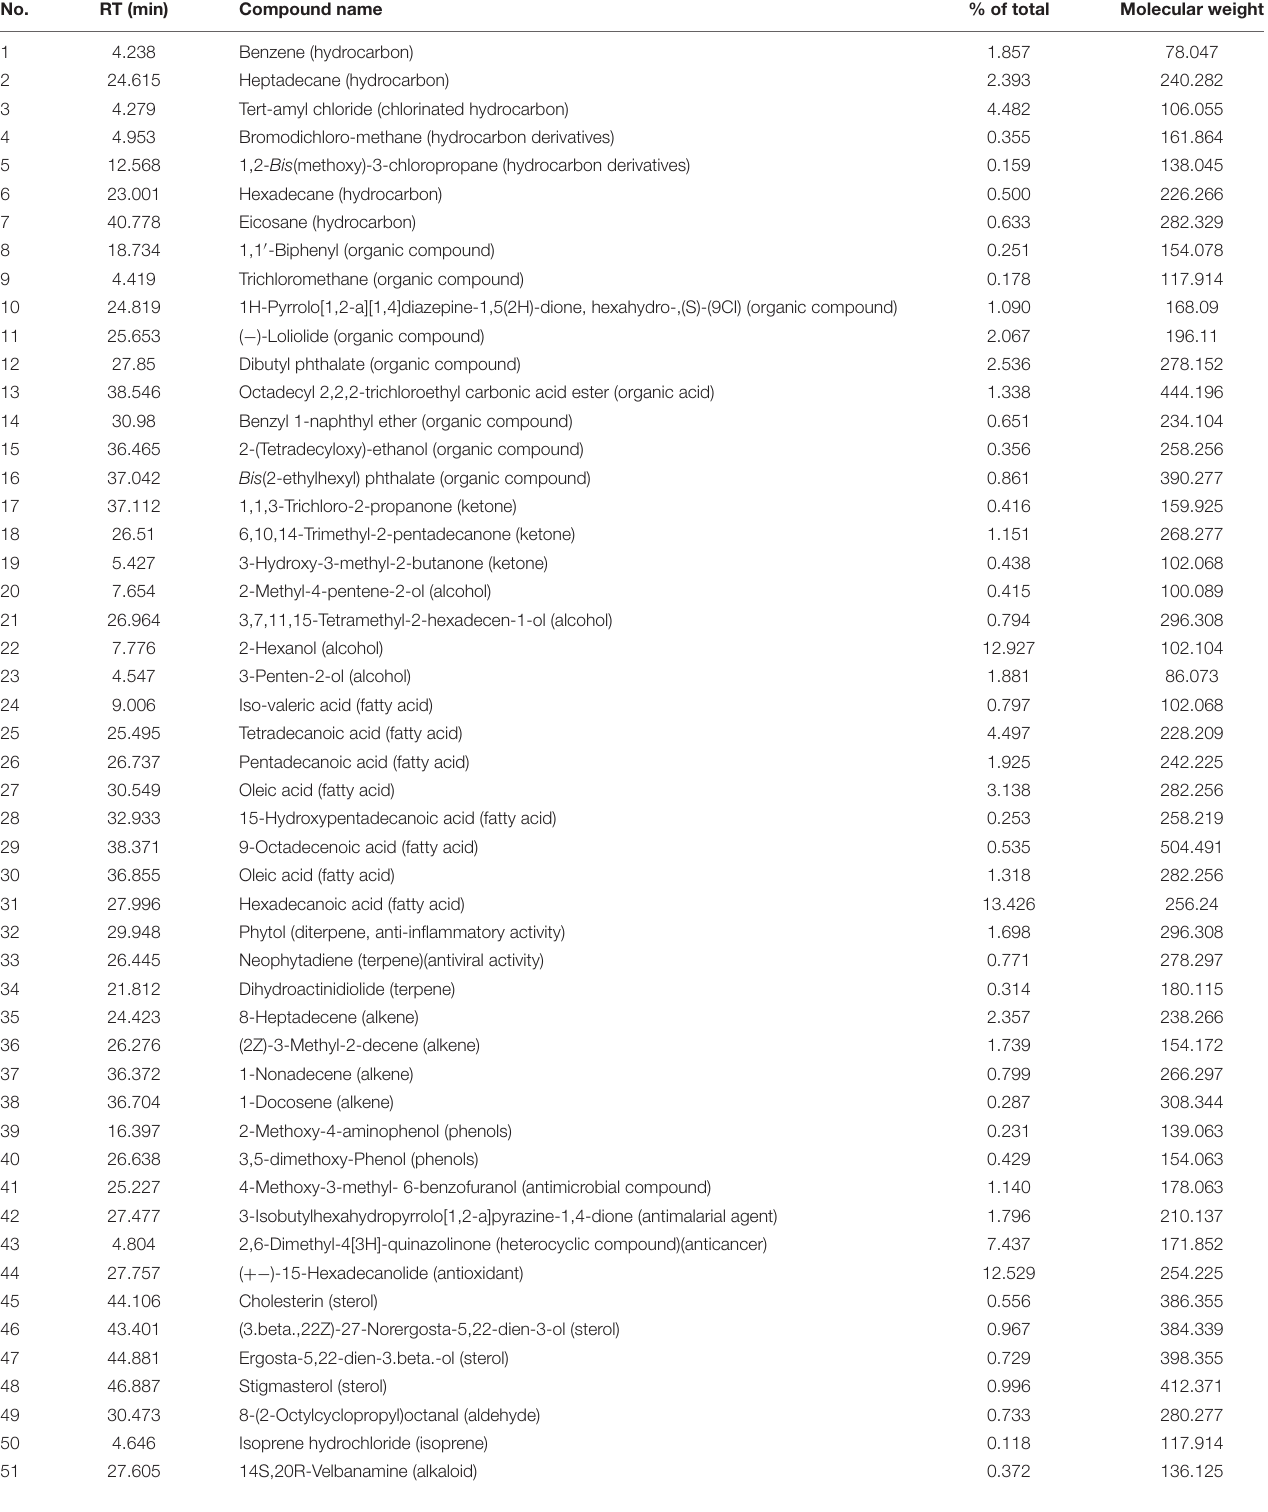
TABLE 1 | Gas chromatography mass spectrometry activity of Amphora coffeaeformis extract.